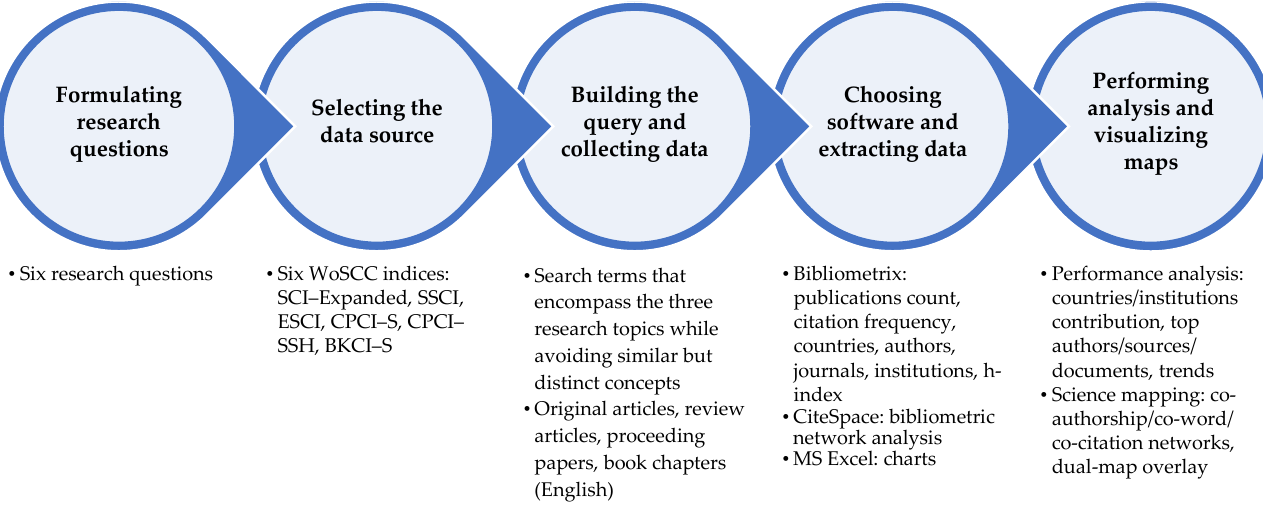
Figure 1. Methodological scheme for the research.